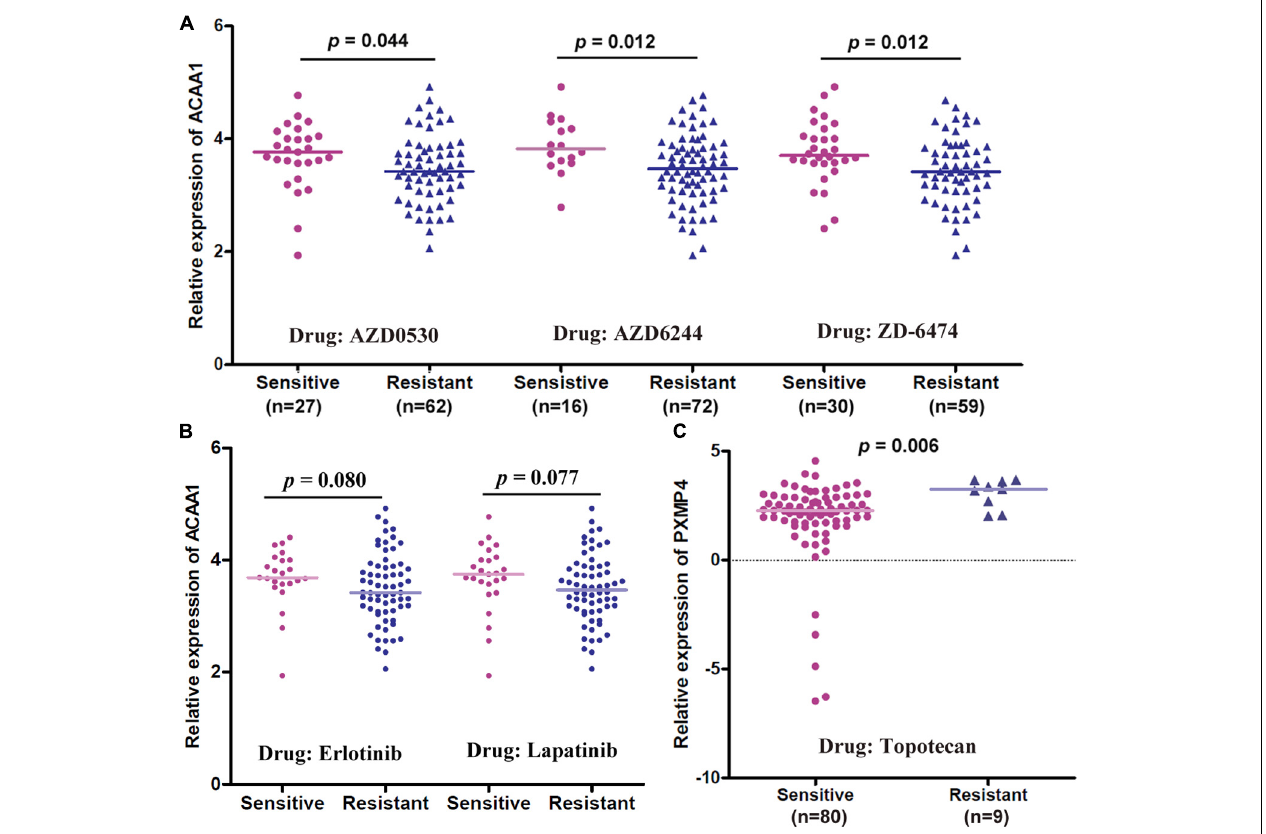
FIGURE 10 | Gene expressional differences of ACAA1 and PXMP4 between NSCLC cell lines with different anti-cancer drug sensitivities. (A) For anti-cancer drugs AZD0530, AZD6244, and ZD6474, ACAA1 was higher expressed in drug-sensitive NSCLC cell lines than the drug-resistant ones. (B) For Erlotinib and Lapatinib, there was a higher trend (0.05 < p < 0.1) of ACAA1 expression in the sensitive cell lines than the resistant ones. (C) PXMP4 was higher expressed in the Topotecan-sensitive NSCLC cell lines than the resistant ones. NSCLC, non-small cell lung cancer. Two independent samples Mann–Whitney U test was used for the comparisons and p < 0.05 was considered